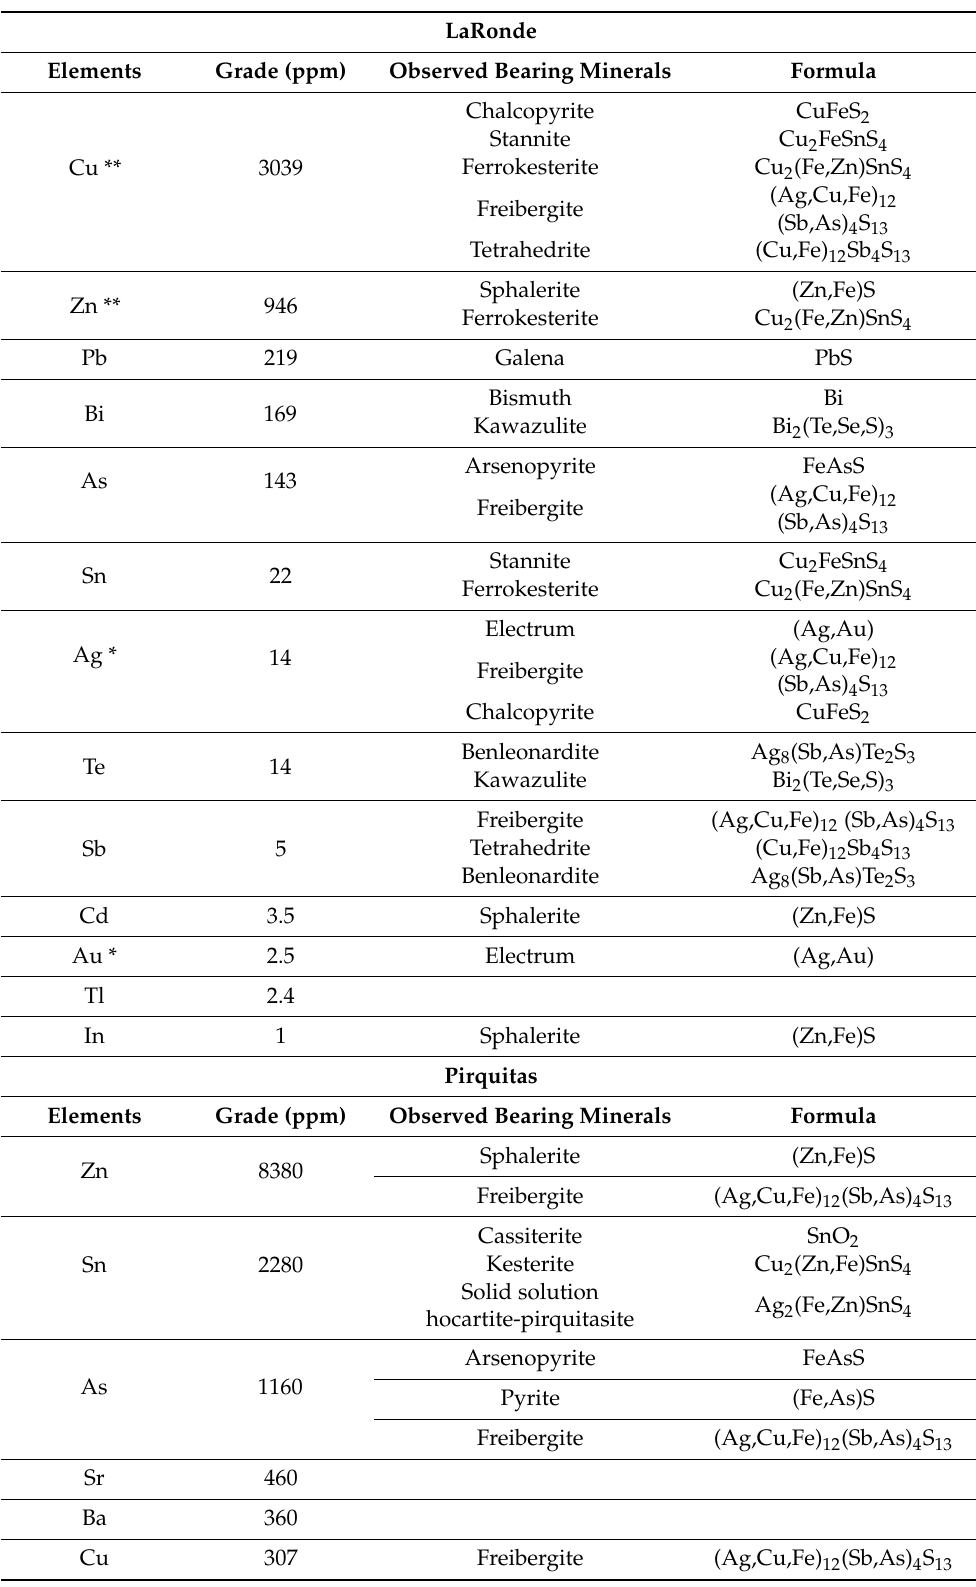
Table 2. Observed bearing minerals of the elements of interest for the ten ores. S, 16.2%; Fe, 15.5%. * Products; **